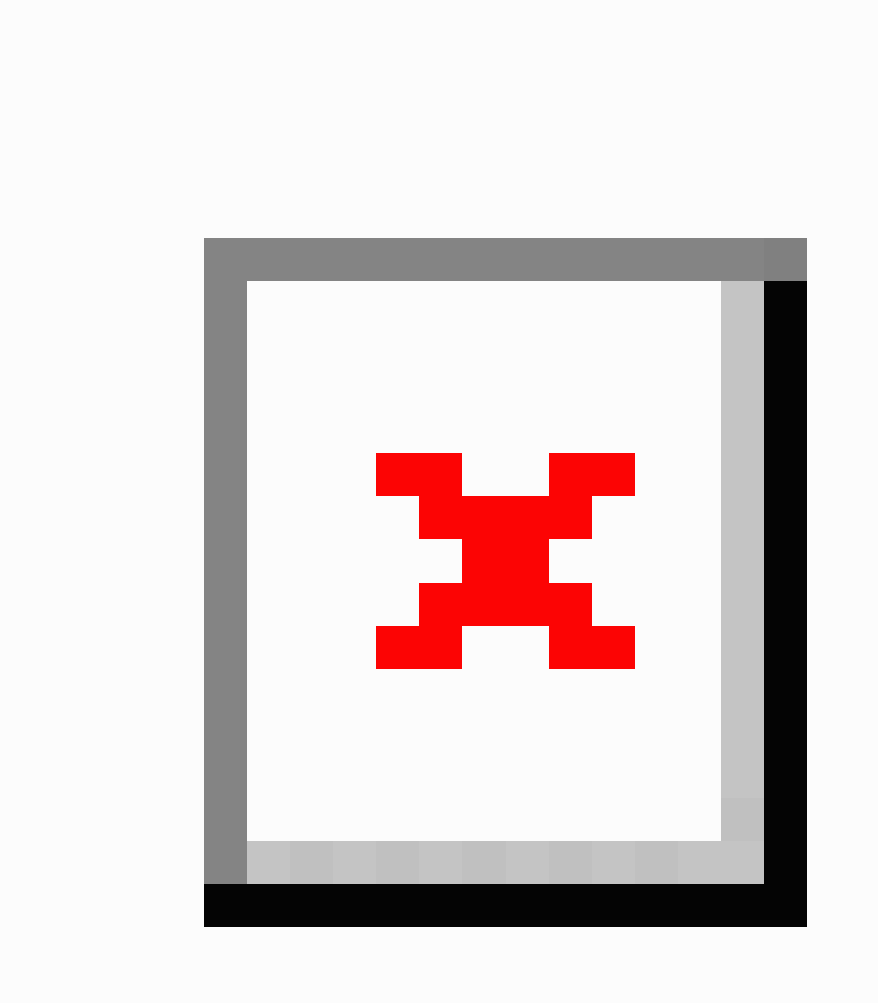
Figure 5. The carcinoma of the prostate visualization and interpretation system (CaP VIS) system showing the right side of the screen where additional information about the patient pathway is seen. There are three sections that show the histopathology report, the pathway details in the format presented in this paper, the annotations section, and a fourth section (hidden) contains pathway statistics. An overlapping window shows in detail the prostate specific antigen (PSA) kinetics before treatment, computed for this pathway. The toolbar above the histopathology section allows the user to zoom and pan the plotted pathway (in Figure 4), as well as to save the plotted figure to file, search for particular patient pathway, or navigate to the previous or next patient pathway. Doubling time (DT) and velocity